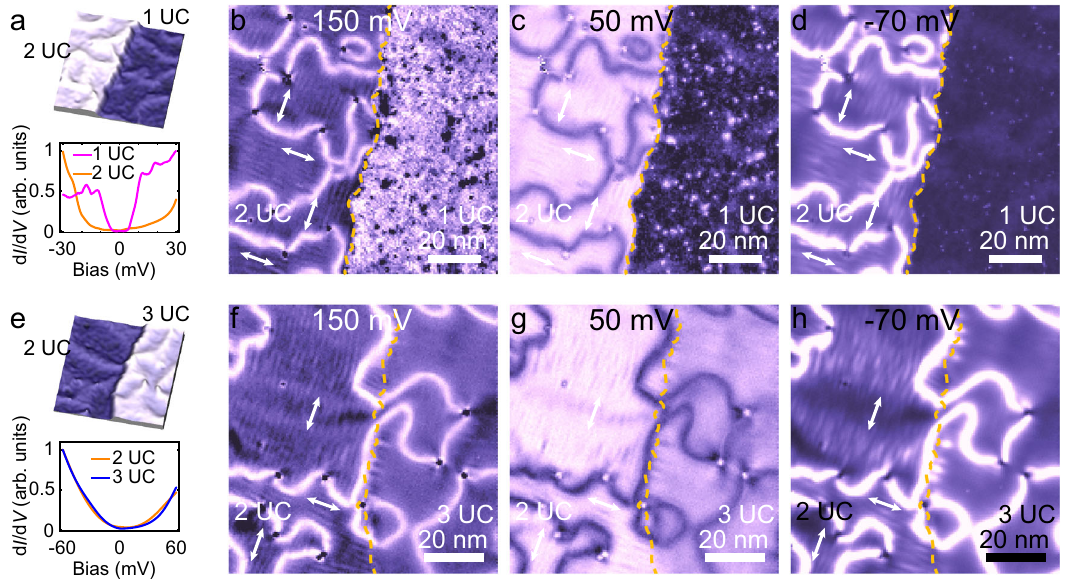
Fig. 2 Film thickness dependence of smectic phase. a Upper panel: STM topographic image of an area including 1 UC and 2 UC FeSe/STO (90 nm × 90